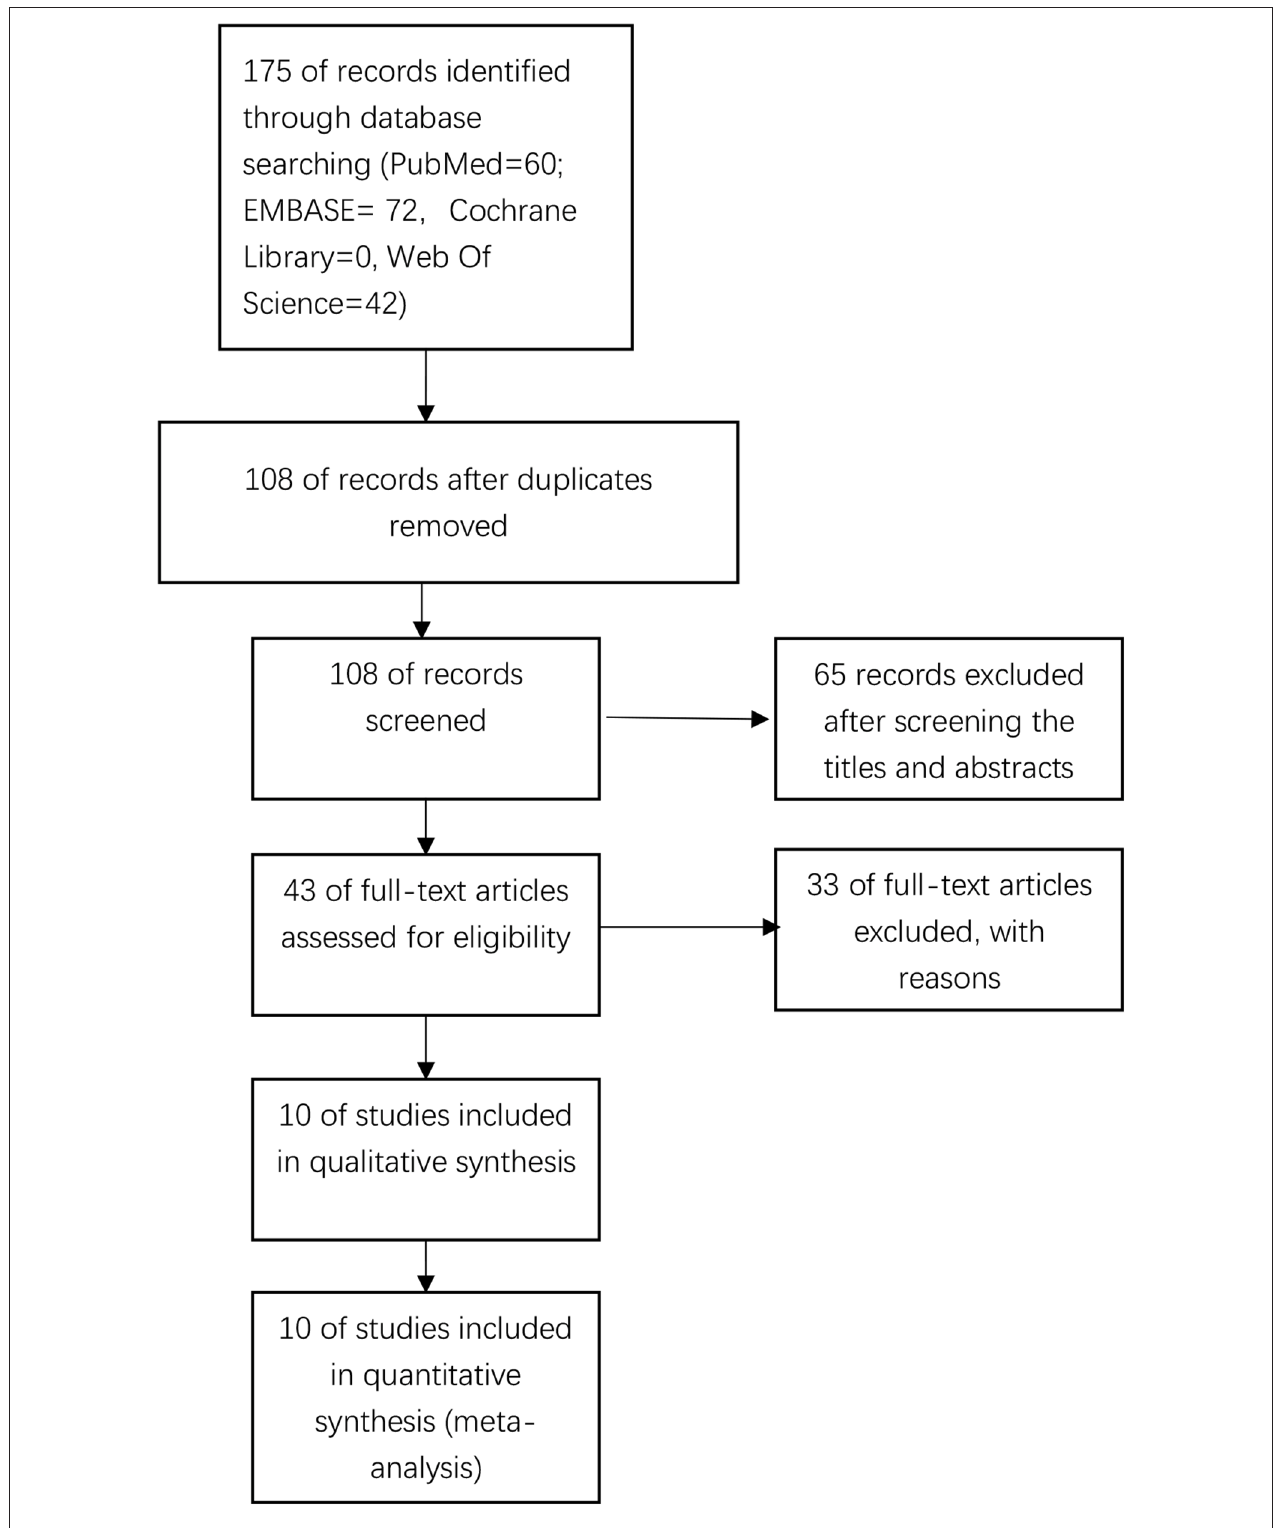
FIGURE 1 | Flow diagram of the study selection